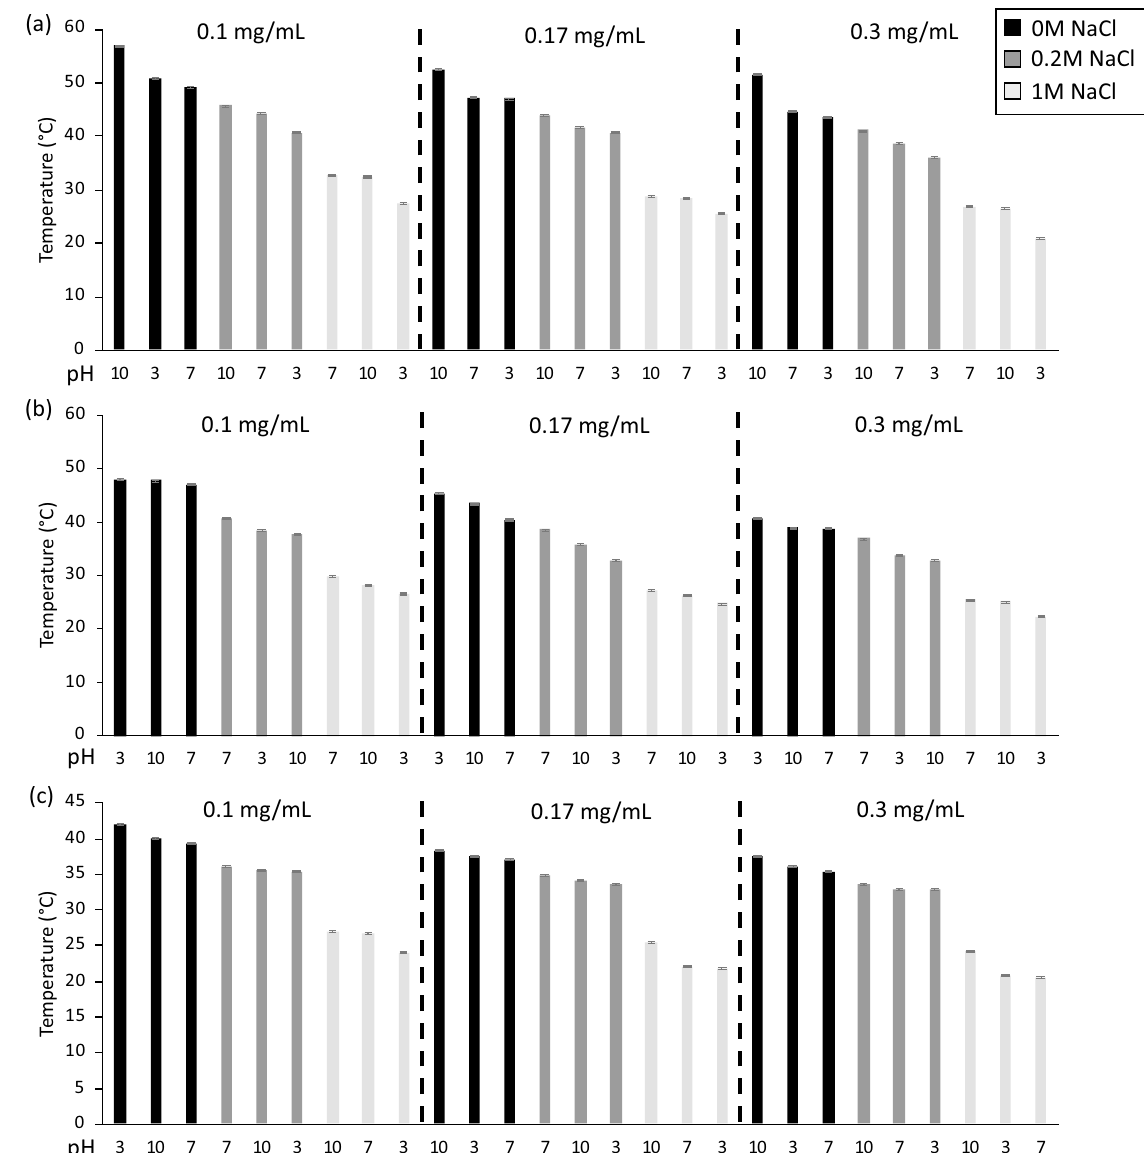
Figure 2. LCST of aqueous solution samples sorted from highest to lowest with respect to the concentration of ( a ) ELP, ( b ) ELP/ELP-PEI800, and ( c ) ELP/ELP-PEI10K as determined by dynamic light scattering. Statistical significance between samples can be found in Supplementary Figure